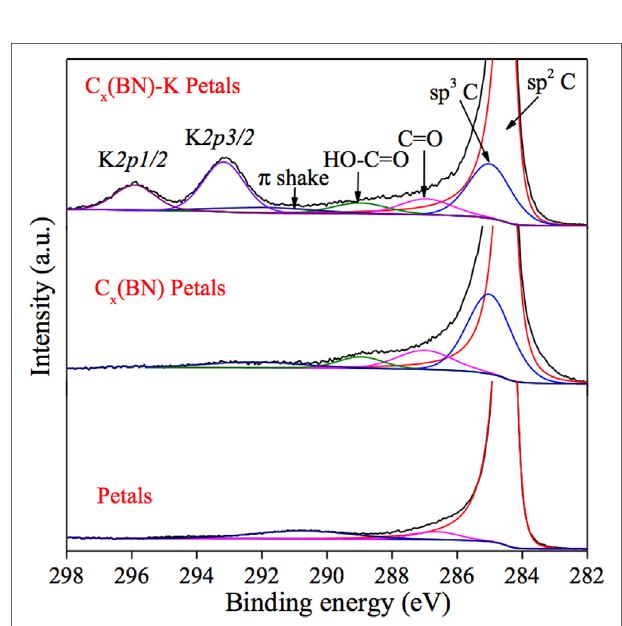
FigUre 6 | C 1S and K 2p spectra for graphitic petals, C x (BN) petals, and C x (BN)-K petals.